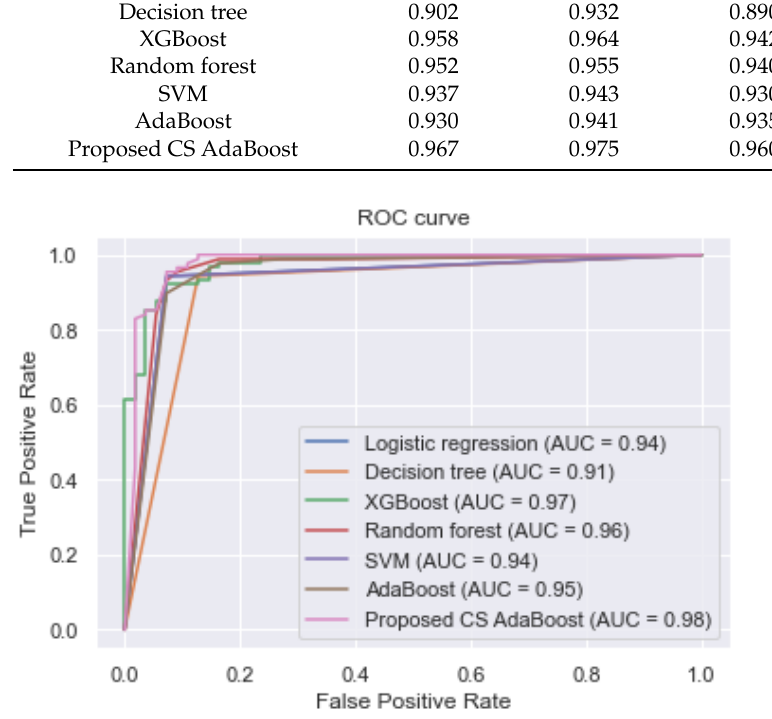
Figure 2. ROC curve of the classifiers trained using the complete feature set.